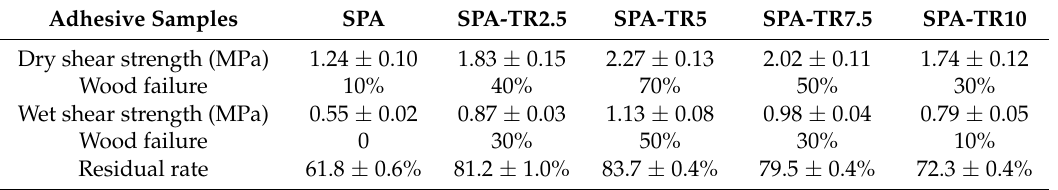
Table 3. The shear strength and residual rate of the different adhesive samples. Adhesive